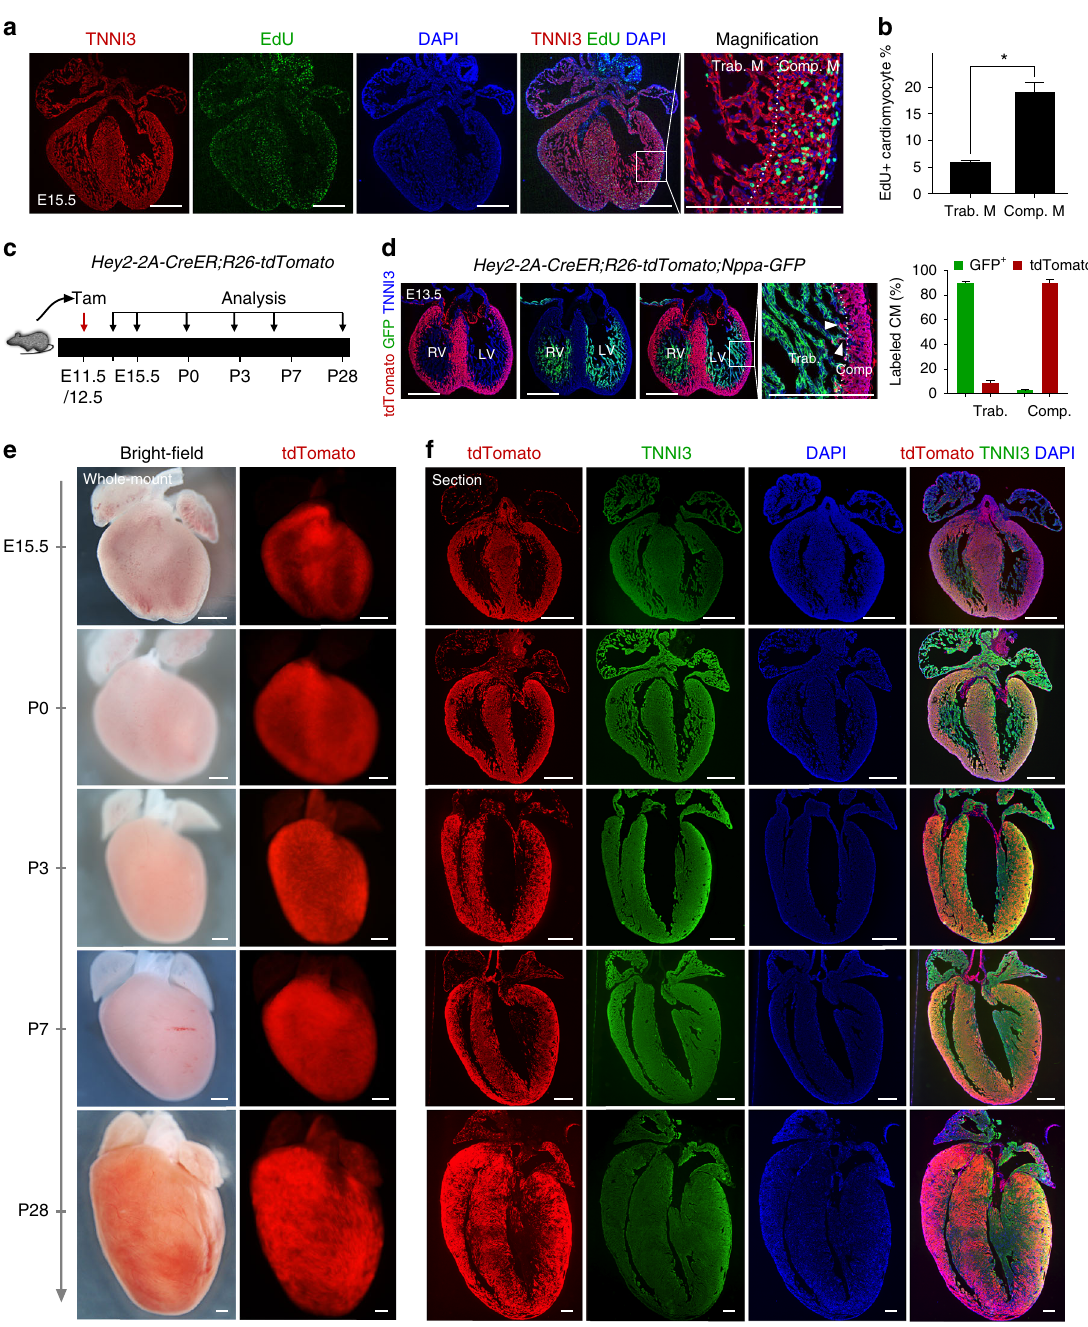
Fig. 4 Compact myocardium contributes to the middle and outer myocardial wall. a Immunostaining for EdU and TNNI3 on E15.5 heart sections. Dotted line in magni fi ed image denotes border between trabecular myocardium (Trab. M) and compact myocardium (Comp. M). b Quanti fi cation of the percentage of EdU + cardiomyocytes in Trab. M or Comp. M. * P < 0.05; Data are mean ± s.e.m.; n = 4. c Schematic diagram showing the time point for tamoxifen (Tam) induction and tissue analysis. d Immunostaining for tdTomato, GFP, and TNNI3 on Hey2-2A-CreER;R26-tdTomato;Nppa-GFP heart section. Dotted line indicate border between Trab. and Comp. myocardium. Arrowheads indicate tdTomato+ cardiomyocytes (CM) in trab. layer. Quanti fi cation of the percentage of labeled CM in Trab. or Comp. is shown on the right panel . Data are mean ± s.e.m.; n = 4. e Whole-mount bright- fi eld and fl uorescence views of hearts collected from Hey2-2A-CreER;R26-tdTomato mice. f Immunostaining for tdTomato and TNNI3 on heart sections. Each image is a representative of four individual samples. Scale bars, 500 µ